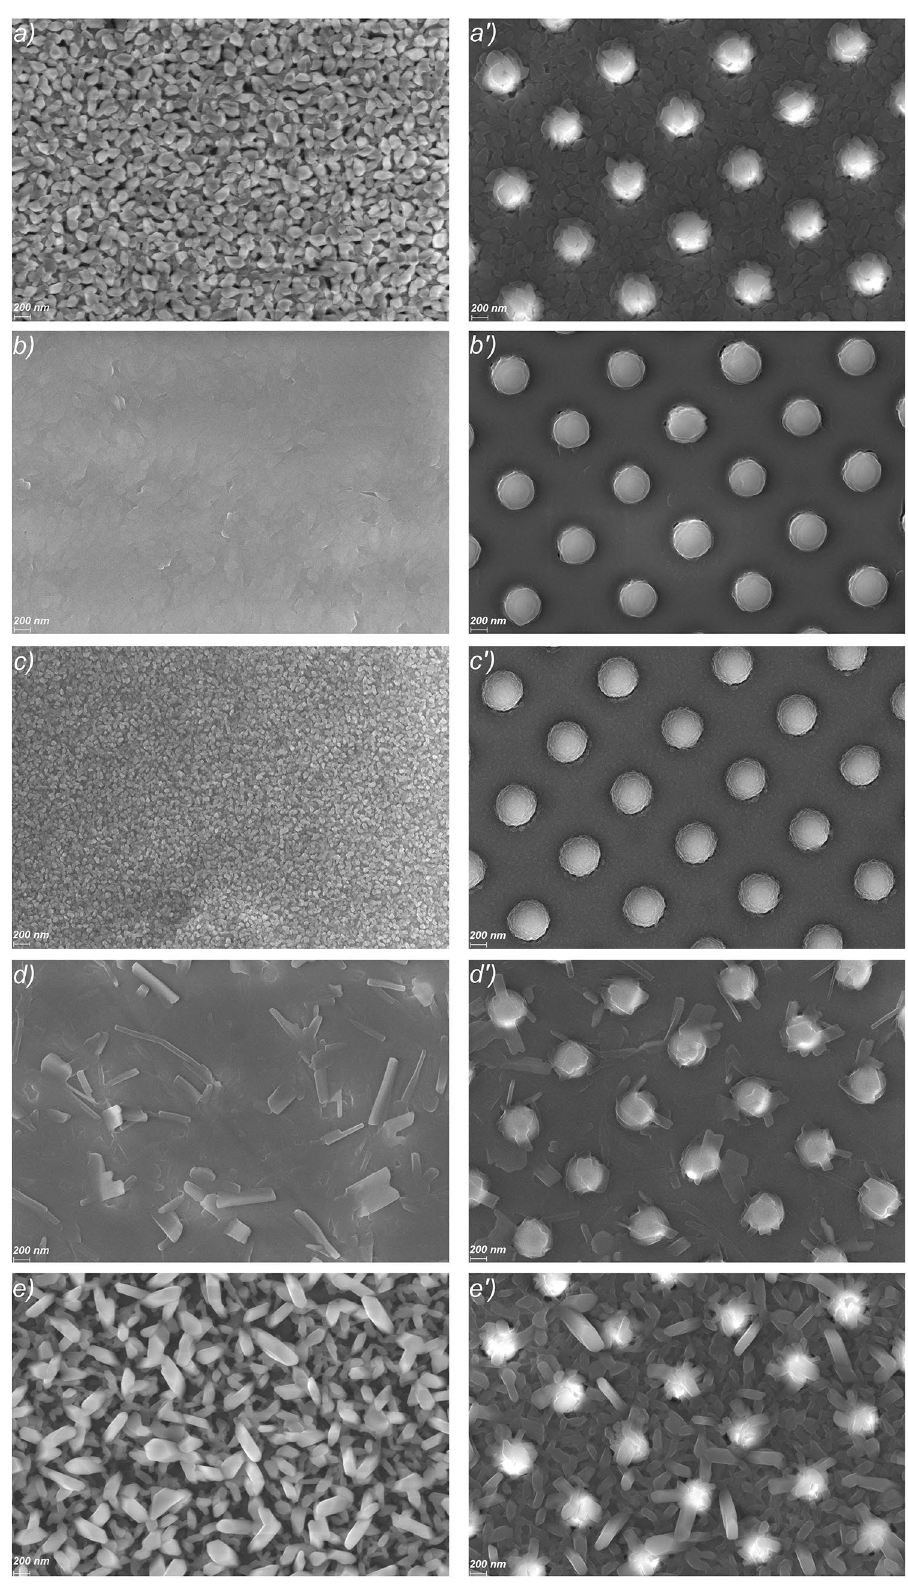
Figure 4. SEM images of the nucleobases, adenine, cytosine, guanine, thymine and uracil deposited on flat ITO/glass substrates ( a – e ) and nano-patterned ITO/glass substrates ( a’ – e’